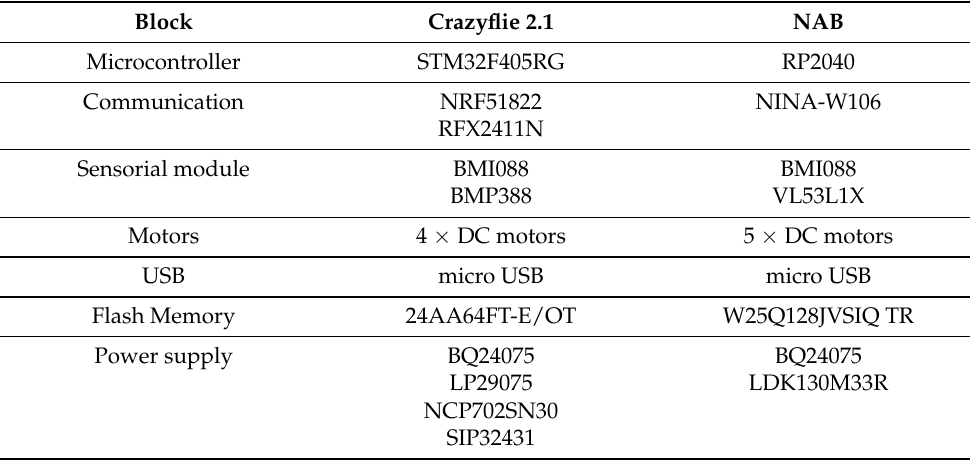
Table 2. Components in each block of Crazyflie 2.1 and NAB. Block Crazyflie